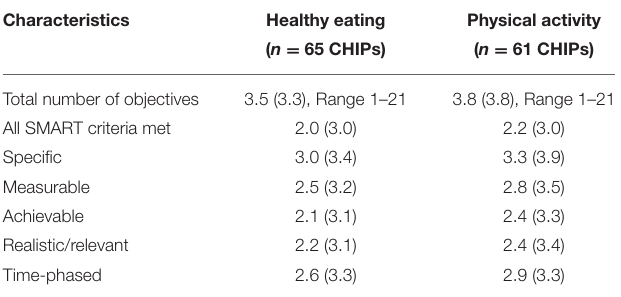
TABLE 3 | Characteristics of objectives among CHIPs with objectives related to healthy eating or physical activity, mean